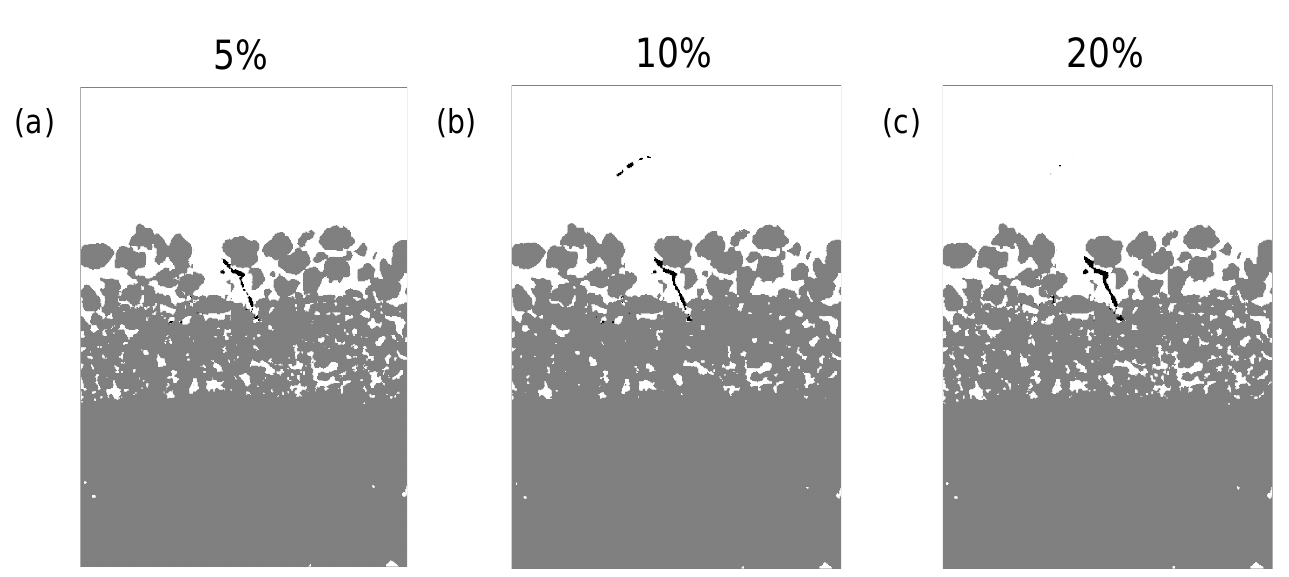
Figure 9. Segmented image slices of sample A, day 11 corresponding to the classifier trained based on ( a ) 5%, ( b ) 10%, and ( c ) 20% of the image